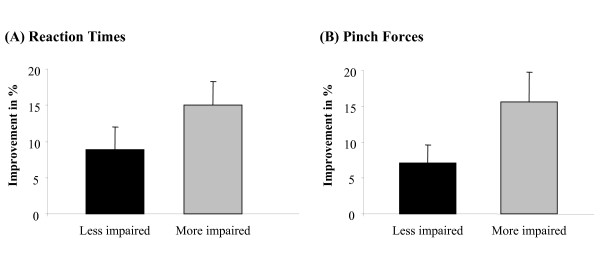
Effects of tDCS and impairment of patients. Patients were stratified in two groups according to their ability to perform skilled ADL-like motor tasks. Less impaired patients (n = 7) were able to perform the Jebsen-Taylor-Task (JTT) and more impaired patients were not able to perform the JTT. After stratification tDCS-induced improvement of reaction time (A) and pinch force (B) was calculated for each group. Note, that the improvement was larger in the more impaired group.